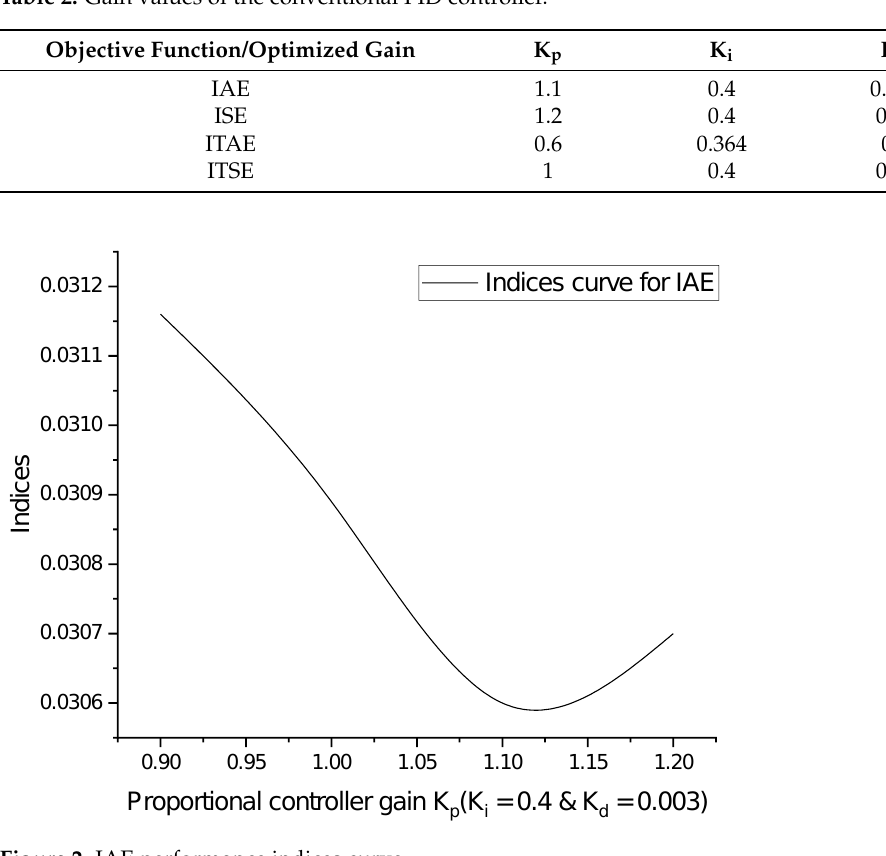
(K = 0.4 & K = 0.003) p i d